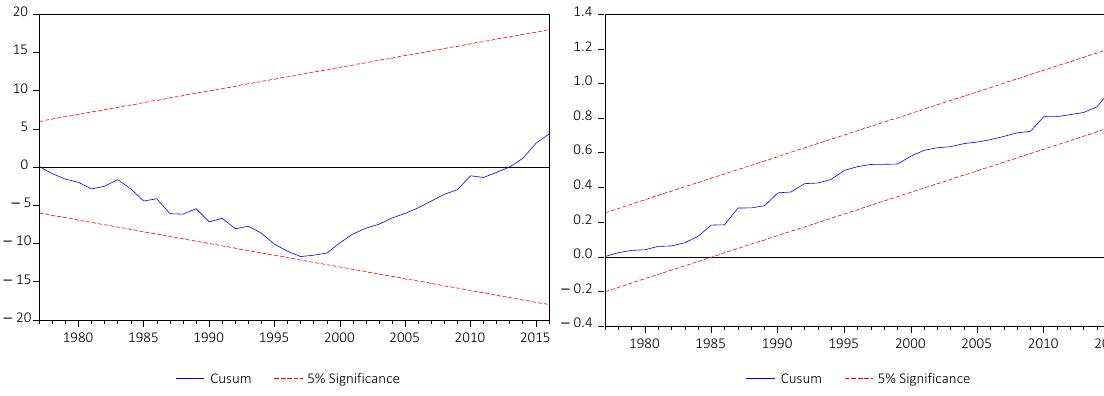
Figure 1. Plots of CUSUM and CUSUMSQ